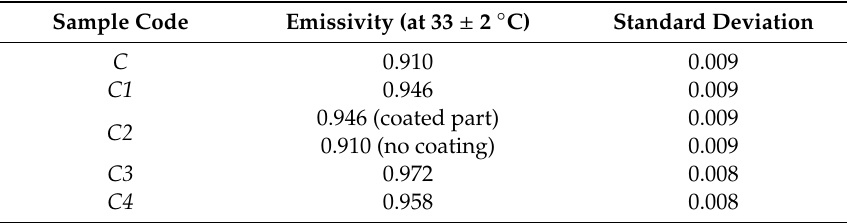
Table 4. Emissivity measurement results of investigated